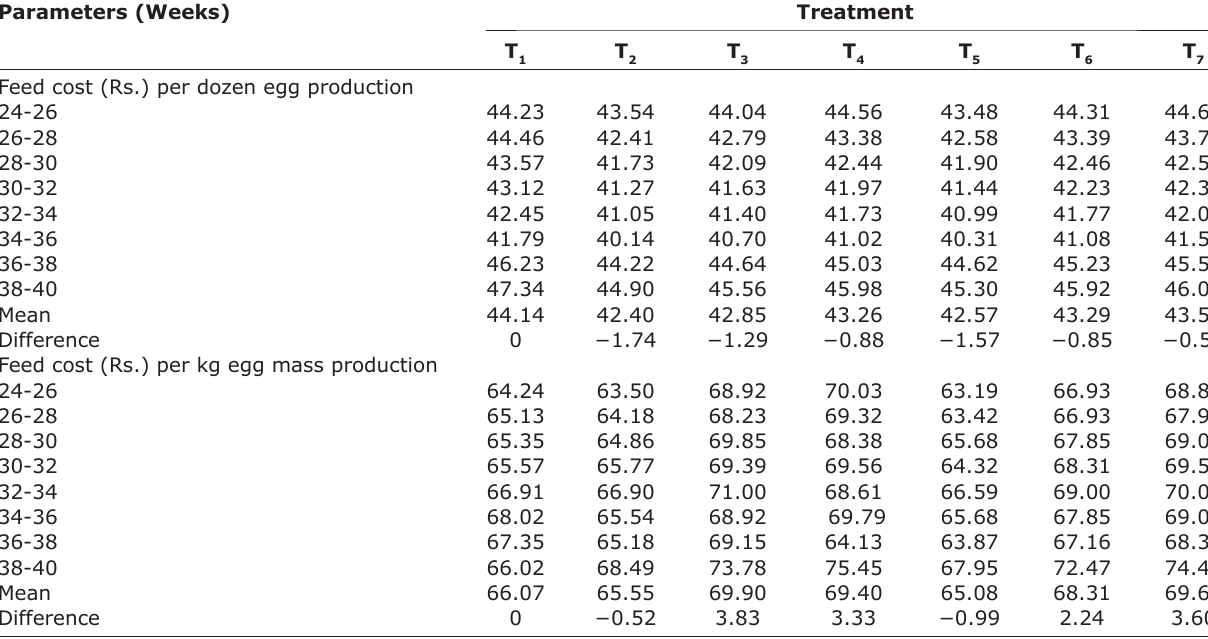
Table-4: Average feed cost (Rs.) per dozen egg production and per kg egg mass production during progressive age (weeks) under different dietary treatments. Parameters